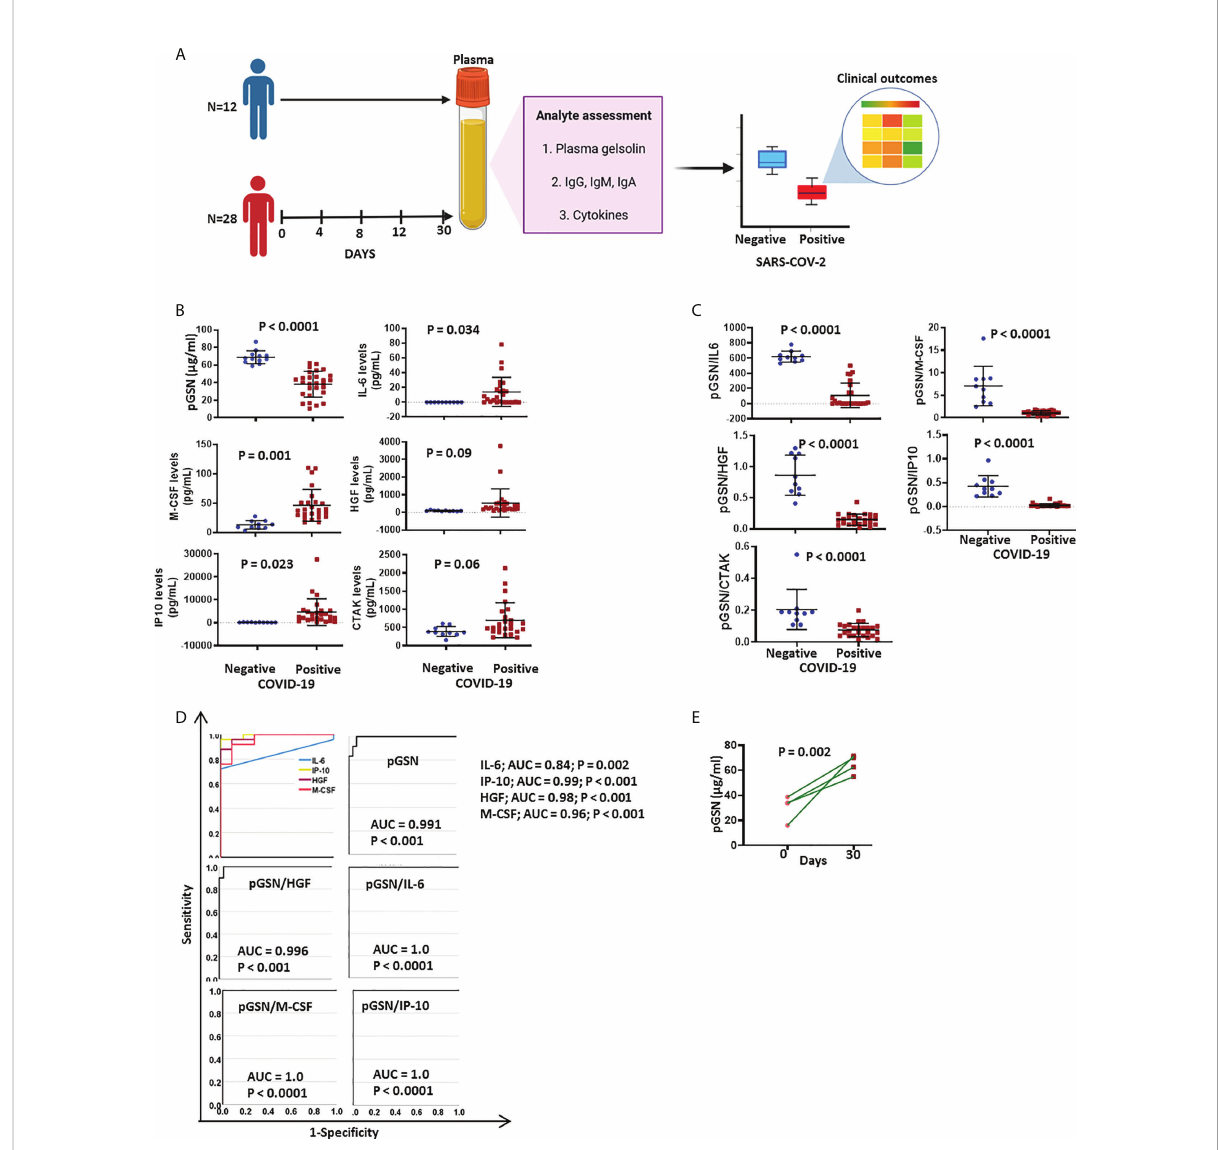
FIGURE 1 pGSN ’ s combination with IL-6, IP-10 and M-CSF signi fi cantly discriminates COVID-19 positive patients from negative subjects. (A) 28 samples were serially collected from PCR-con fi rmed SARS-CoV-2-infected patients and 12 samples collected from non-COVID-19 controls. Samples were analyzed for the levels of pGSN, cytokines and anti-SARS-COV-2 antibodies. The mean levels of the analyte were compared between COVID-19 negative and positive subjects. The test performances of the biomarkers against clinical outcomes were analyzed. (B) The mean ± SEM levels of pGSN, IL-6, IP-10, M-CSF, HGF and CTAK were detected and compared between COVID-19 and non-COVID-19 patients. (C) The ratio of pGSN and cytokines were calculated and used as multi-analyte diagnostic panels. The mean ± SEM levels of pGSN/IL-6, pGSN/M-CSF, pGSN/HGF, pGSN/ IP-10 and pGSN/CTAK were determined and compared between COVID-19 and non-COVID-19 subjects. (D) The test performances of pGSN, cytokines (IL-6, IP-10, HGF, M-CSF) and multi-analyte panels (pGSN/HGF, pGSN/IL-6, pGSN/M-CSF and pGSN/IP-10) in differentiating COVID-19 patients from non-COVID-19 subjects were determined using receiving operating characteristic (ROC) curves. (E) pGSN levels in blood collected on day 0 and 30 were compared. P-values were calculated by independent sample